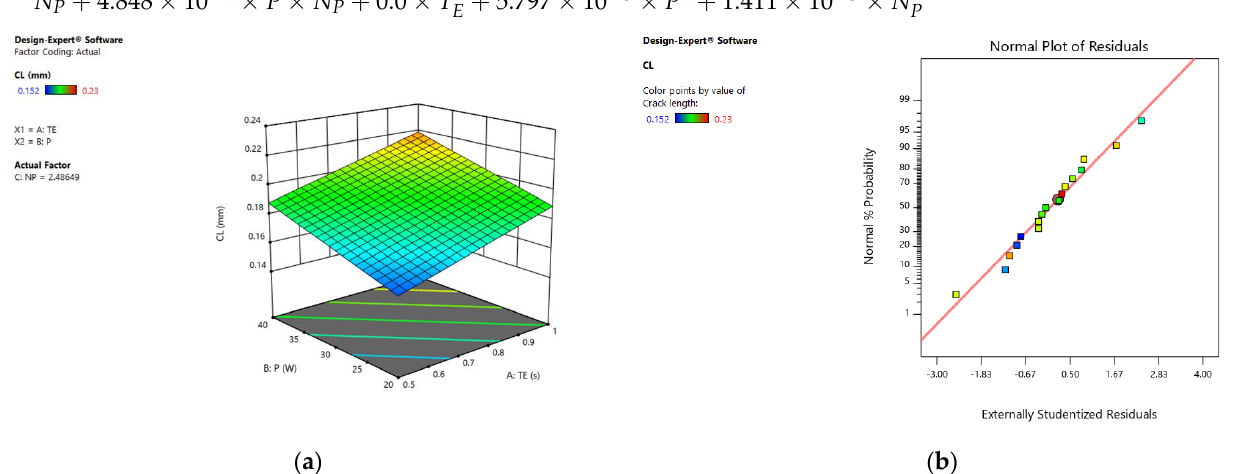
Figure 12. ANOVA model results for CL at 0.1 wt.% CNPs: ( a ) 3D response surface and ( b ) normal residuals plot.